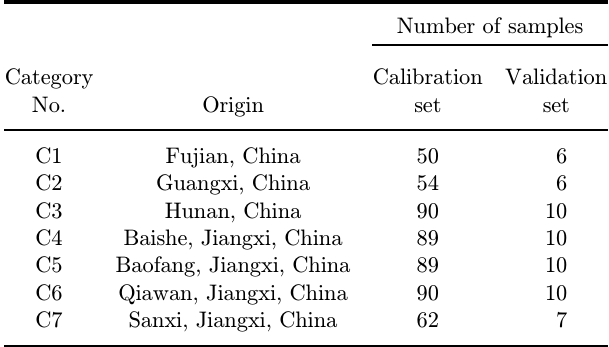
Table 1. The origins of the samples in the